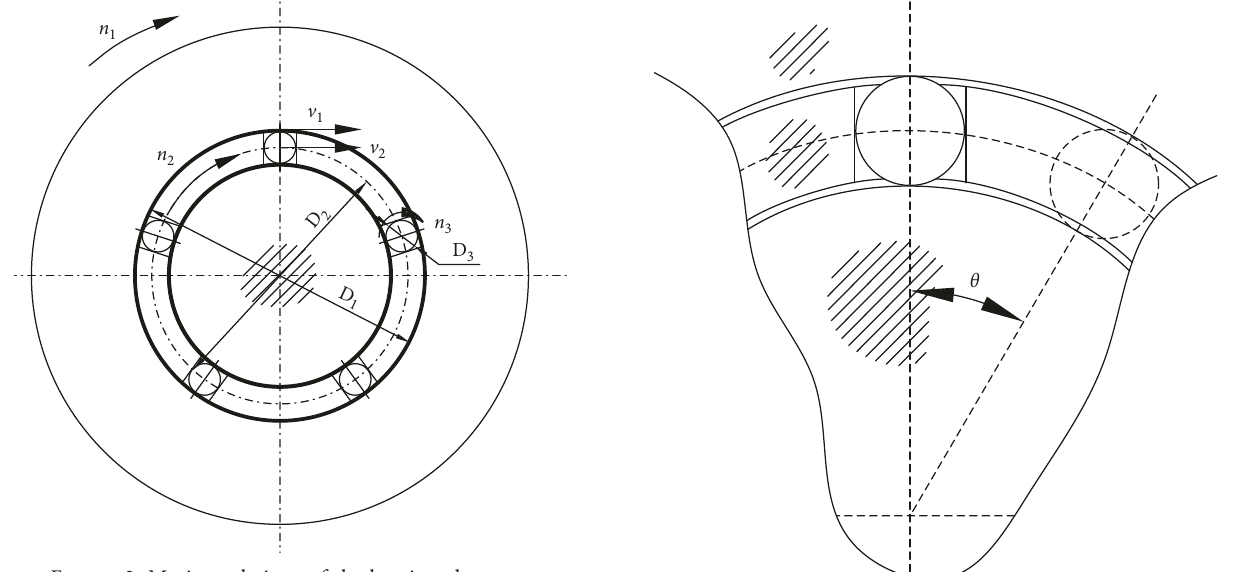
Figure 2: Motion relations of the bearing elements.